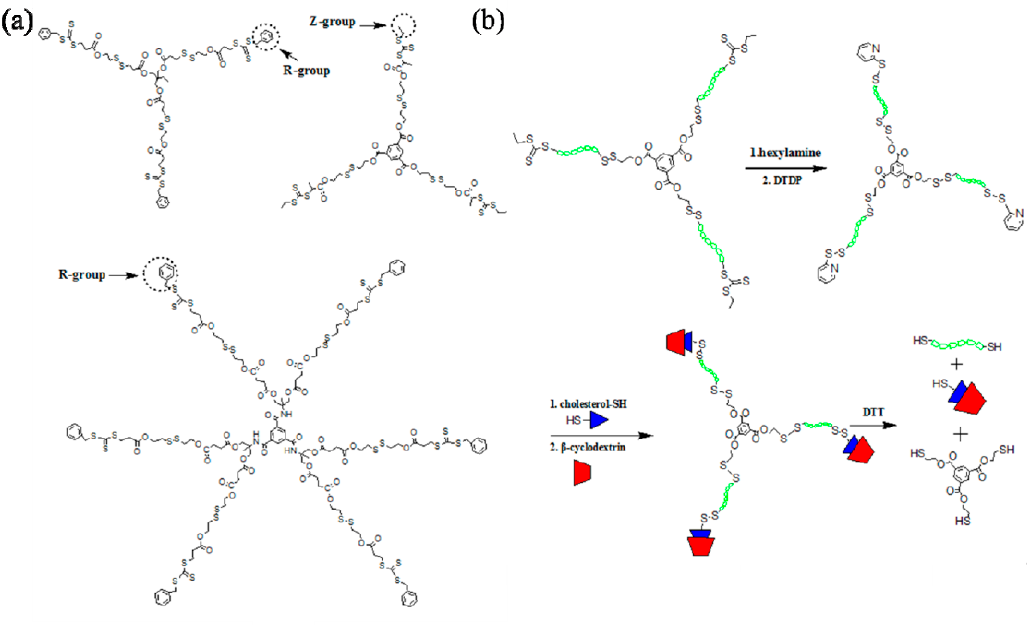
Figure 2. ( a ) Multi-armed RAFT agents with biodegradable disulfide intra-linkers: three-armed RAFT agent with R -group at the end of each arm; three-armed RAFT agent with Z -group at the end of each arm and six-armed RAFT agent with R -group at the end of each arm; ( b ) Post polymerization modification of the three-armed star polymers with RAFT active center at the end of each arm. Copyright 2009, American Chemical Society.